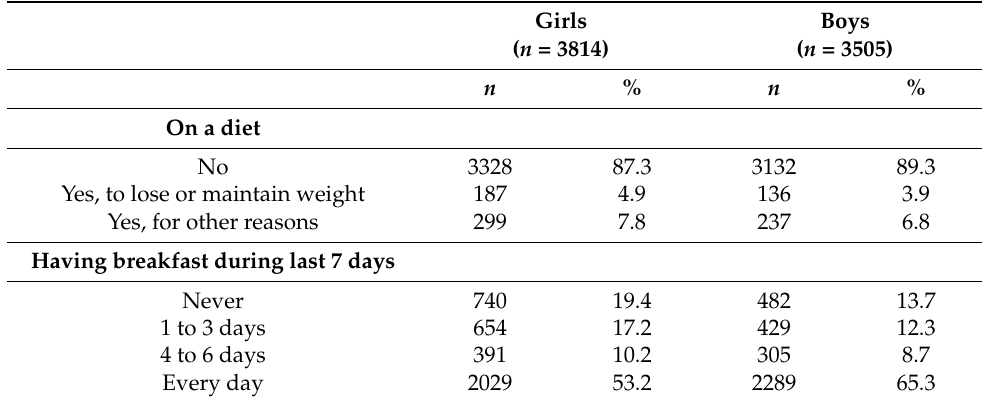
* In the variables age, socioeconomic position and emotional state, the heading “ n ” is substituted for “mean” and “%” for “SD”, Abbreviations: SD = standard deviation; CSE = compulsory secondary education (ISCED 2);